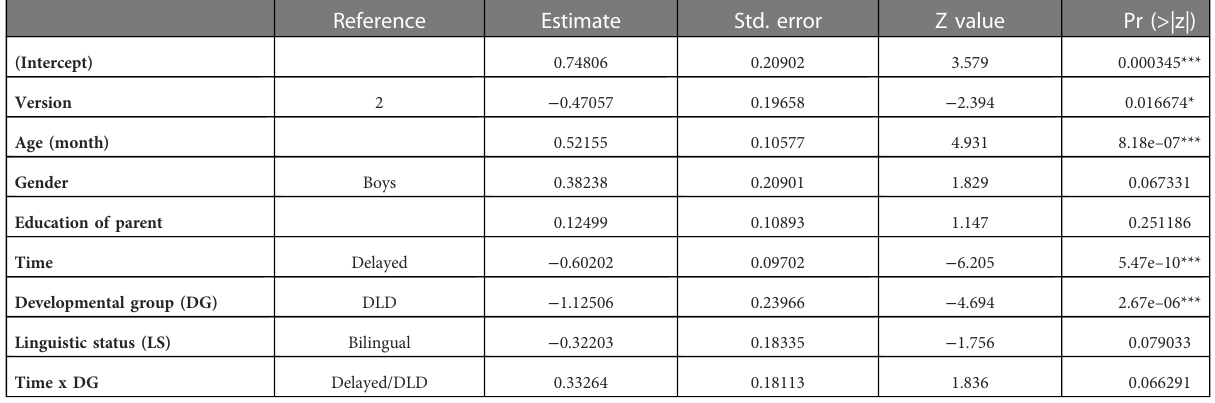
TABLE 8 Results on generalized linear mixed model for phonological